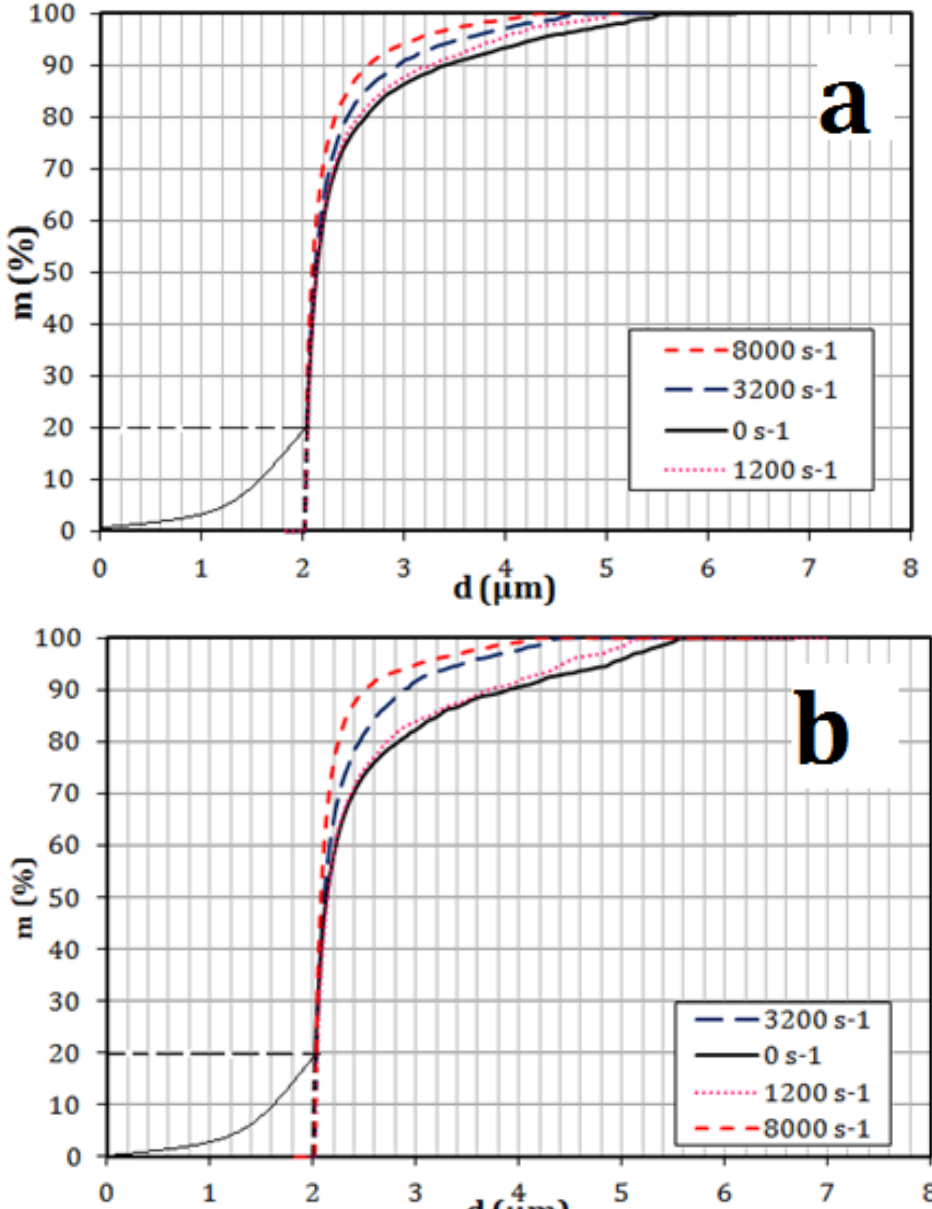
Figure 6. Size distribution of the mass of crude oil droplets in the permeate at ( a ) 200 lm -2 h -1 ( b ) 1000 lm -2 h -1 [44]. The blocking of the pores (slots) of membrane was investigated experimentally by applying an oscillation shear rate over the membrane surface. In these experiments, droplets of crude oil and vegetable oil (stabilized by Tween 20) were used. Similarly to the concentration in permeate, it was found that the blockage of membrane pores was also reduced by the applied oscillating membrane. It was found that the blockage of pores was appreciably reduced by the oscillations applied, as shown in Figure 7. This reduction in blockage was found to be a linear function of the oscillating frequency of the membrane. This means the greater value of the oscillating frequency of the membrane, the lower the blockage of pores. It was shown that the interfacial tension was an essential parameter in pore blockage of the membrane. Oil droplets having a low interfacial tension blockage. However, on the other hand, at high interfacial tension, the blockage in pores